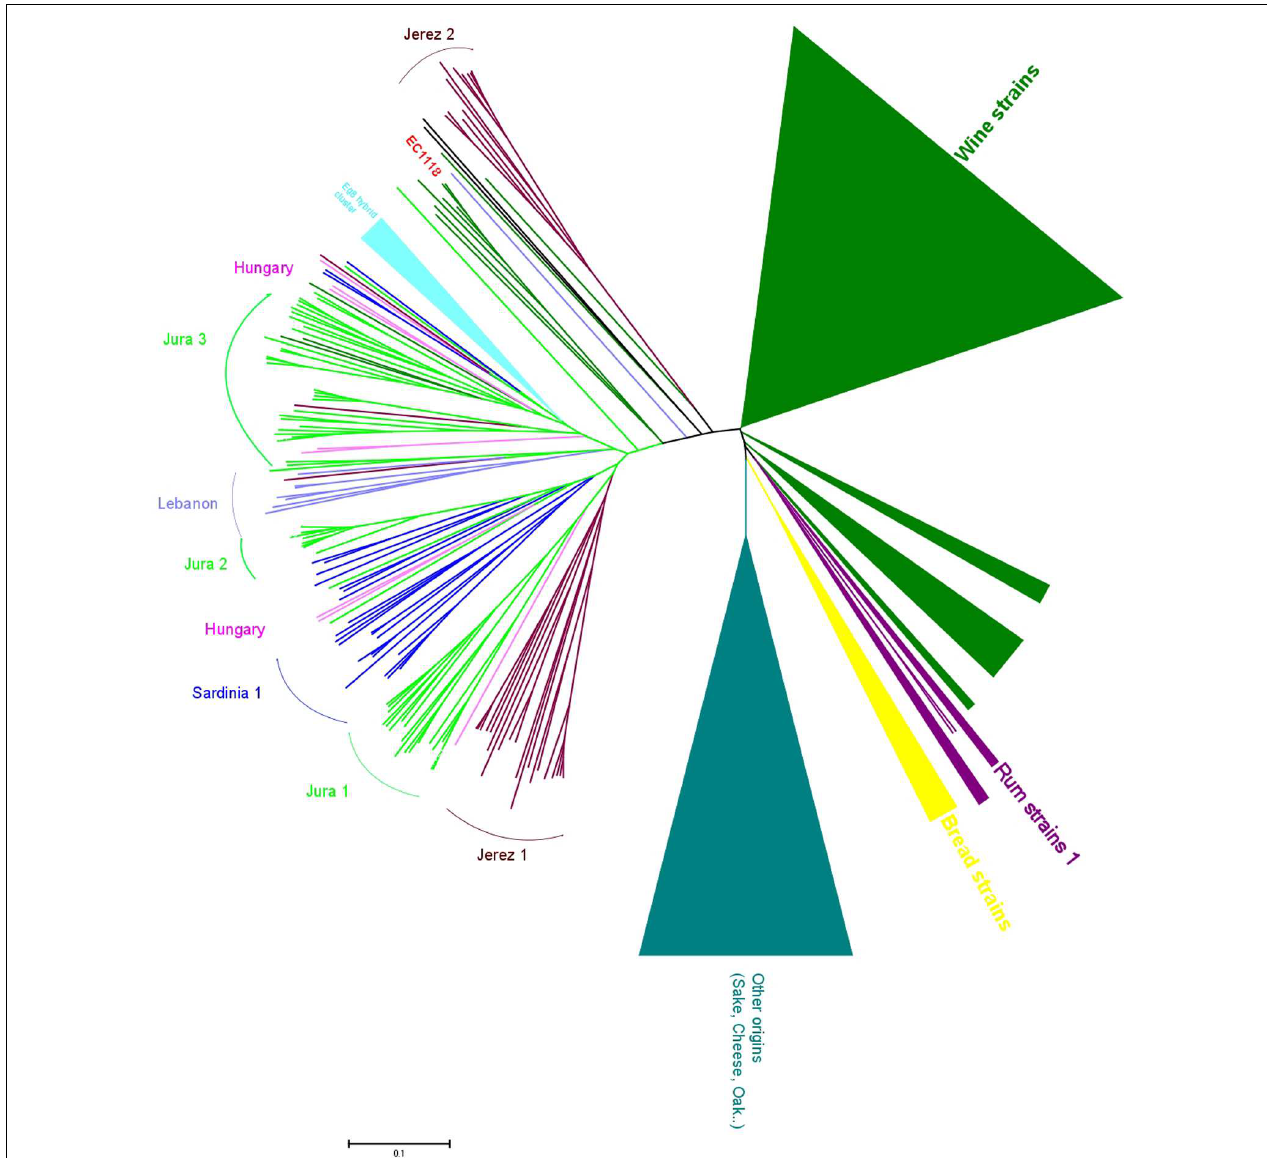
FIGURE 2 | Genomic diversity of flor strains. Neighbor-joining tree built by evaluating the flor strains at 12 microsatellite loci, in comparison with strains of other origins. The tree was built from the Dc chord distance and drawn with MEGA5.22. Clusters of wine strains and other origins have been condensed due to their large size (modified from Legras et al.,